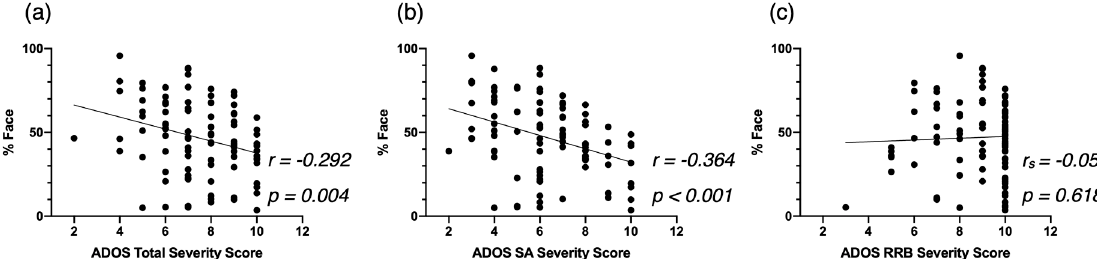
Figure 2. Correlation between %Face and the Autism Diagnostic Observation Schedule—2nd (ADOS-2) Total Severity Score ( a ), the ADOS-2 SA Severity Score ( b ), and the ADOS-2 RRB Severity Score ( c ), at baseline for the cross-sectional Autism Spectrum Disorder (ASD) group.